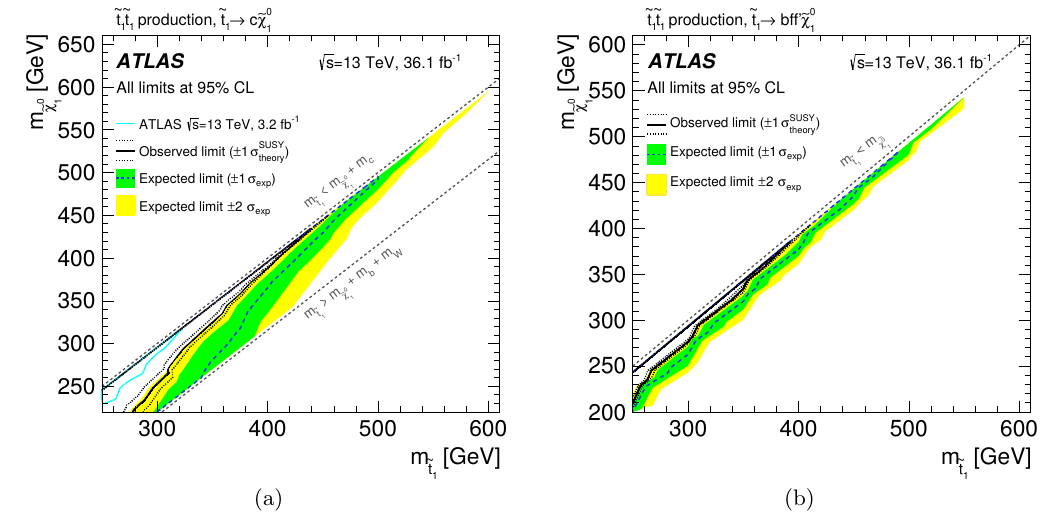
) mass plane for (a) the decay channel 1 (B=100%). The dotted lines 1 p s = 13 TeV [1] using 3 : 2 fb (cid:0) 1 .